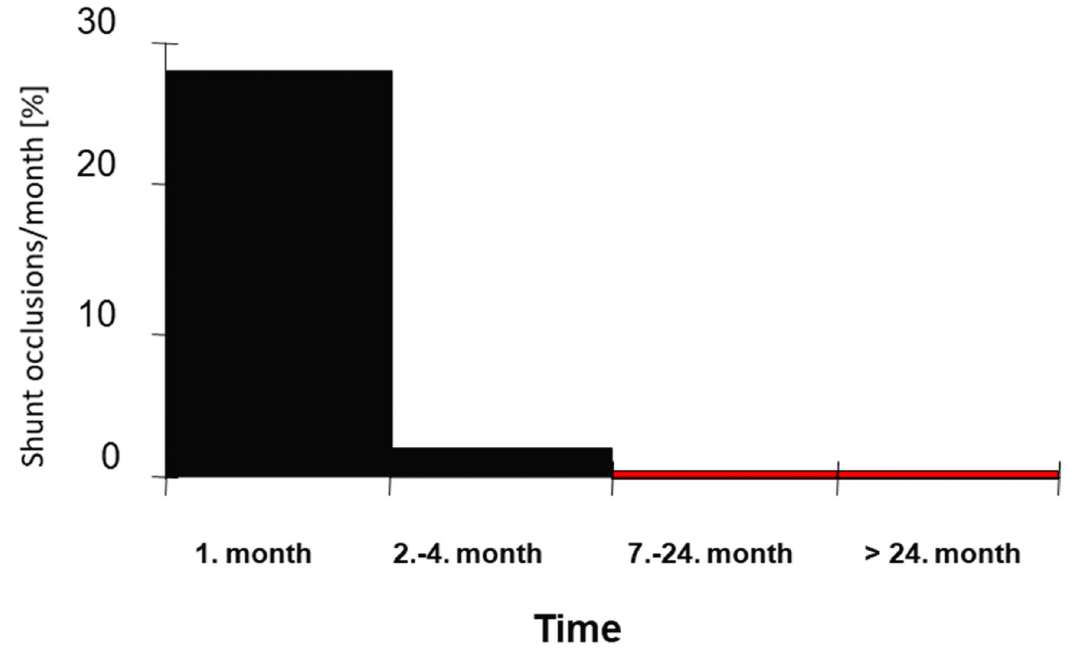
Fig 1. Risk of AVF-occlusion after surgery. Within the first month the occlusion rate was quite high and rapidly decreased during the following months.